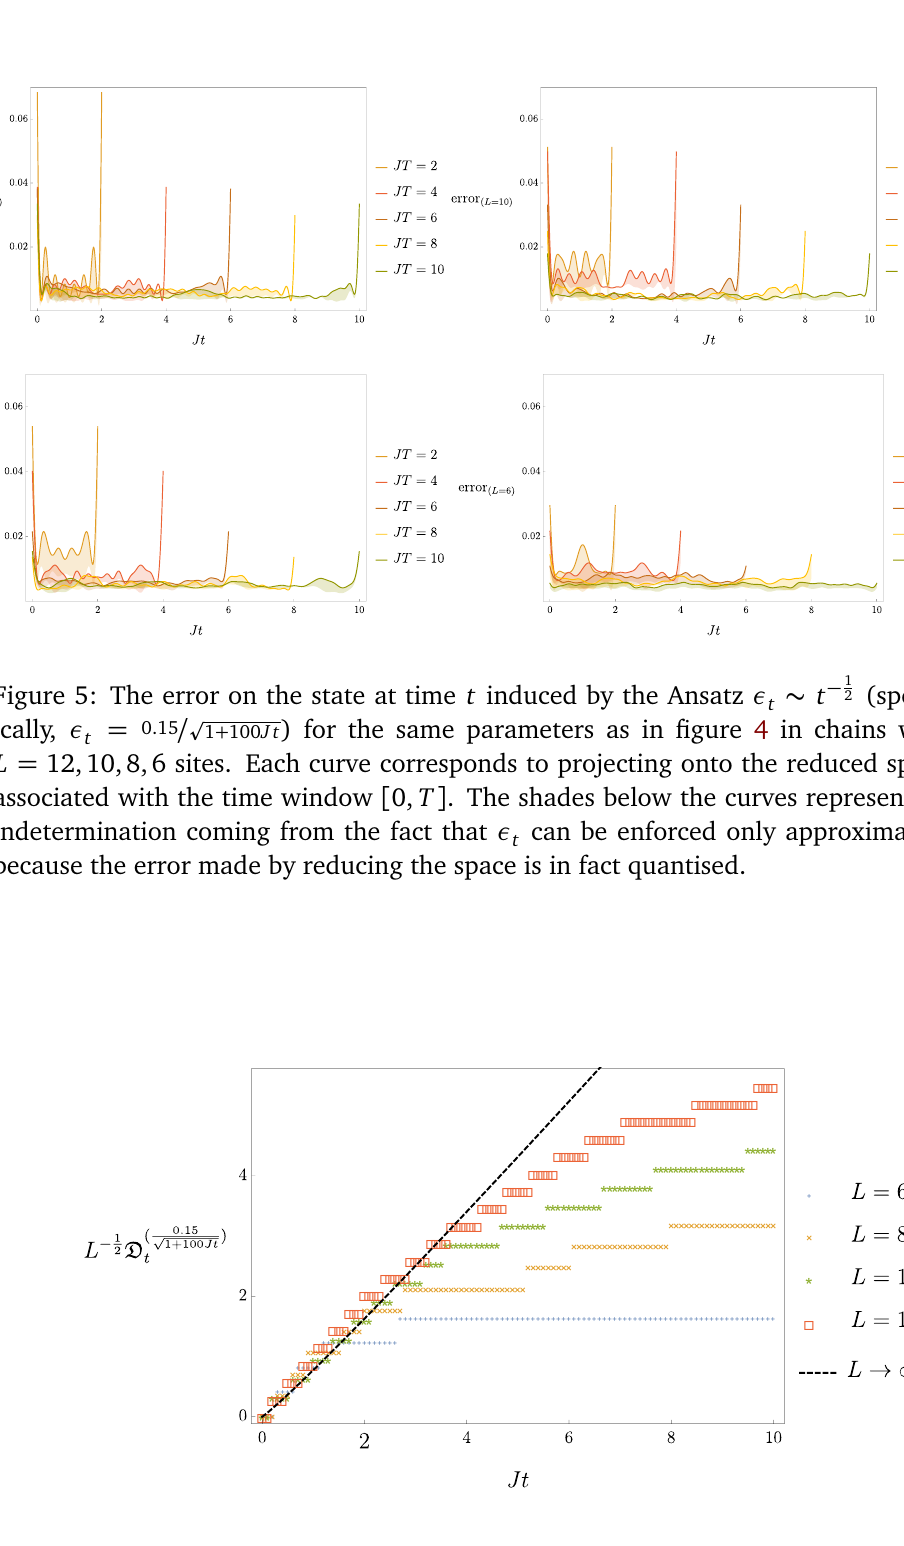
Figure 6: The same as in figure 4 but for a different system. Here the ini- tial state is fully polarised in the z direction and time evolution is generated by (cid:80) σ x σ x + 2 σ y σ y + σ z σ z H = J , which describes an integrable (cid:96) (cid:96) (cid:96) + 1 (cid:96) (cid:96) + 1 (cid:96) (cid:96) + 1